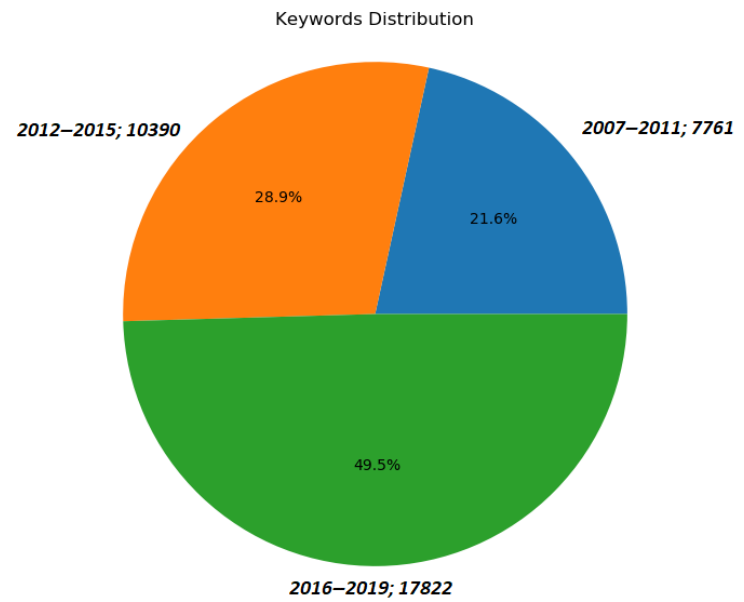
Figure 5. The distribution of keywords according to the three time intervals. Table 3. Top 50 keywords related to ANN